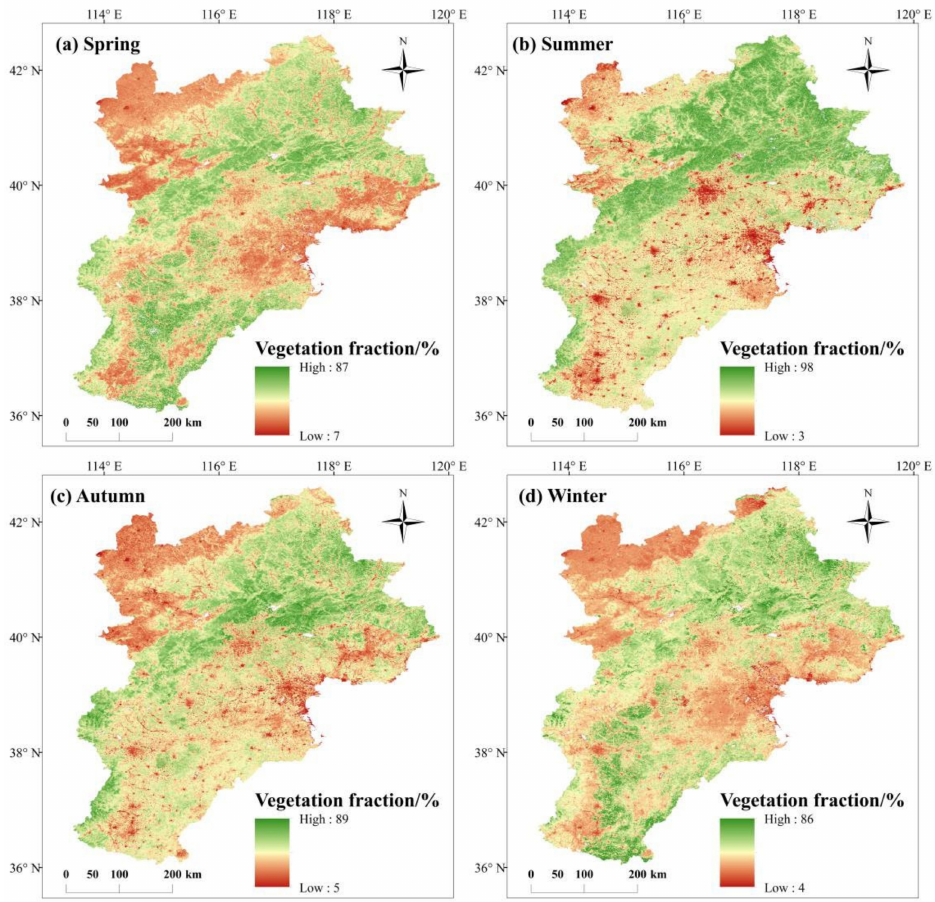
Figure 9. Spatial distribution of the average values of vegetation cover in the Beijing-Tianjin-Hebei region in all seasons. (The ( a – d ) diagram represents the spatial distribution of the average values of vegetation cover in spring, summer, autumn and winter